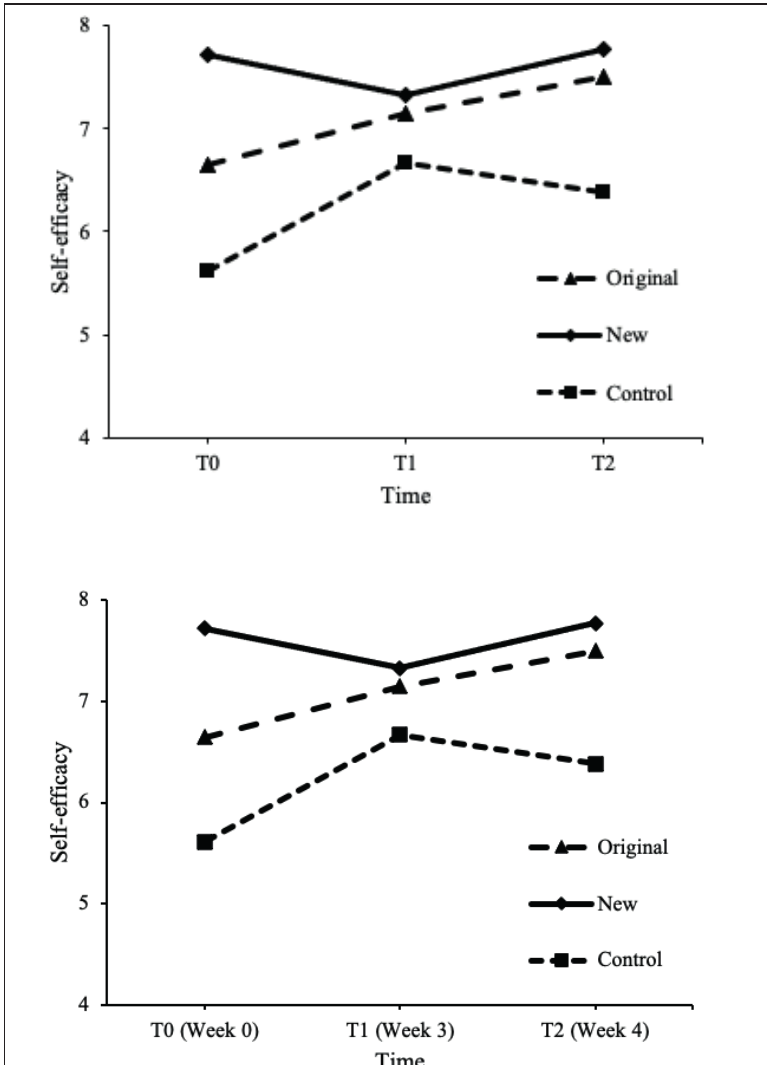
Figure 2 Changes in Self-Efficacy as a Function of Time and